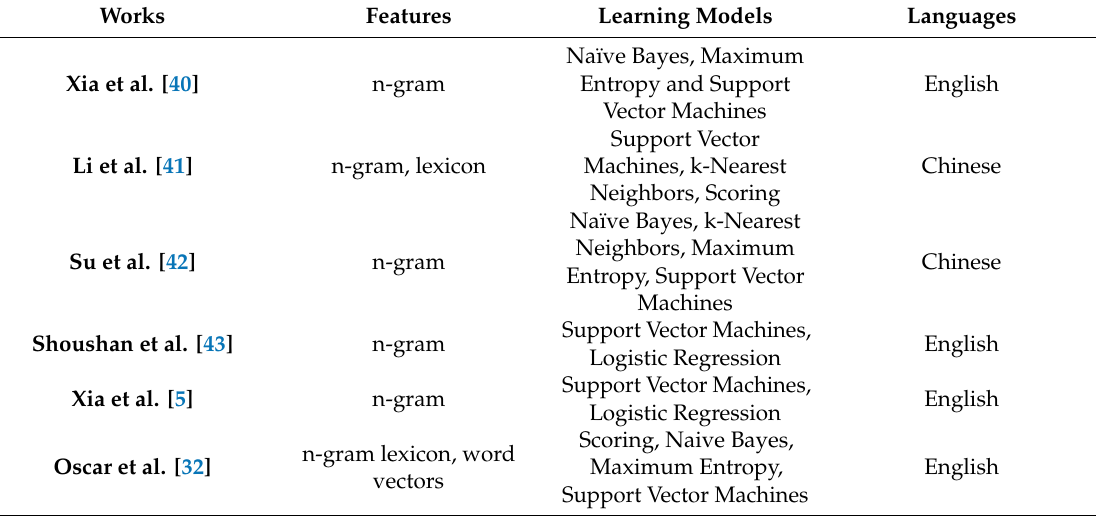
Noticeable researches connected to the application of ensemble learning to sentiment